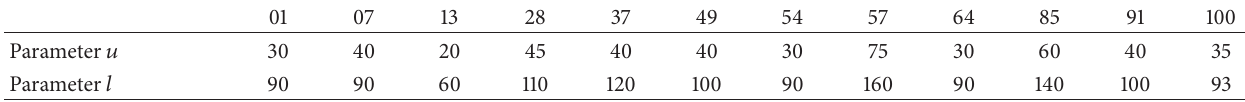
Table 2: Parameters 𝑢 and 𝑙 obtained from the parameter selection based on the psychoacoustic model 1 . 01